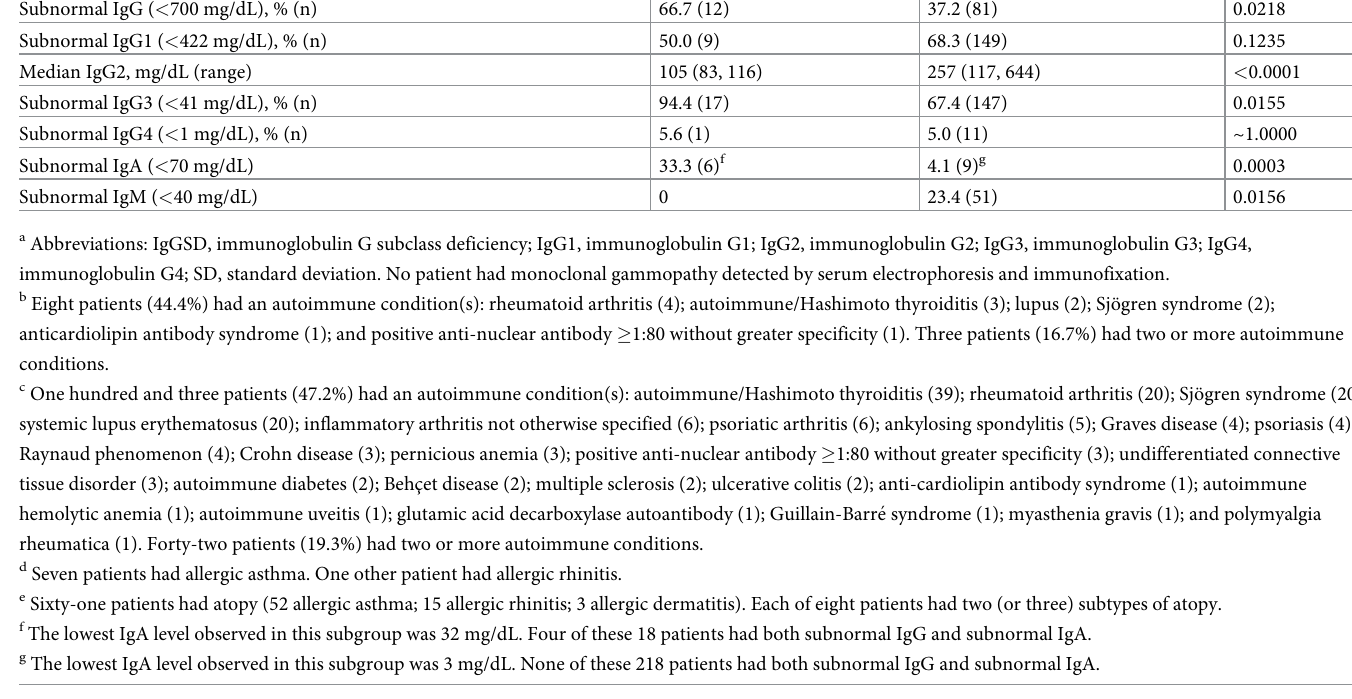
present 18 patients with subnormal IgG2 represent 7.6% of the 236 patients [95% confidence interval: 4.7, 12.0] with IgGSD immunophenotypes without reports of corticosteroid therapy.